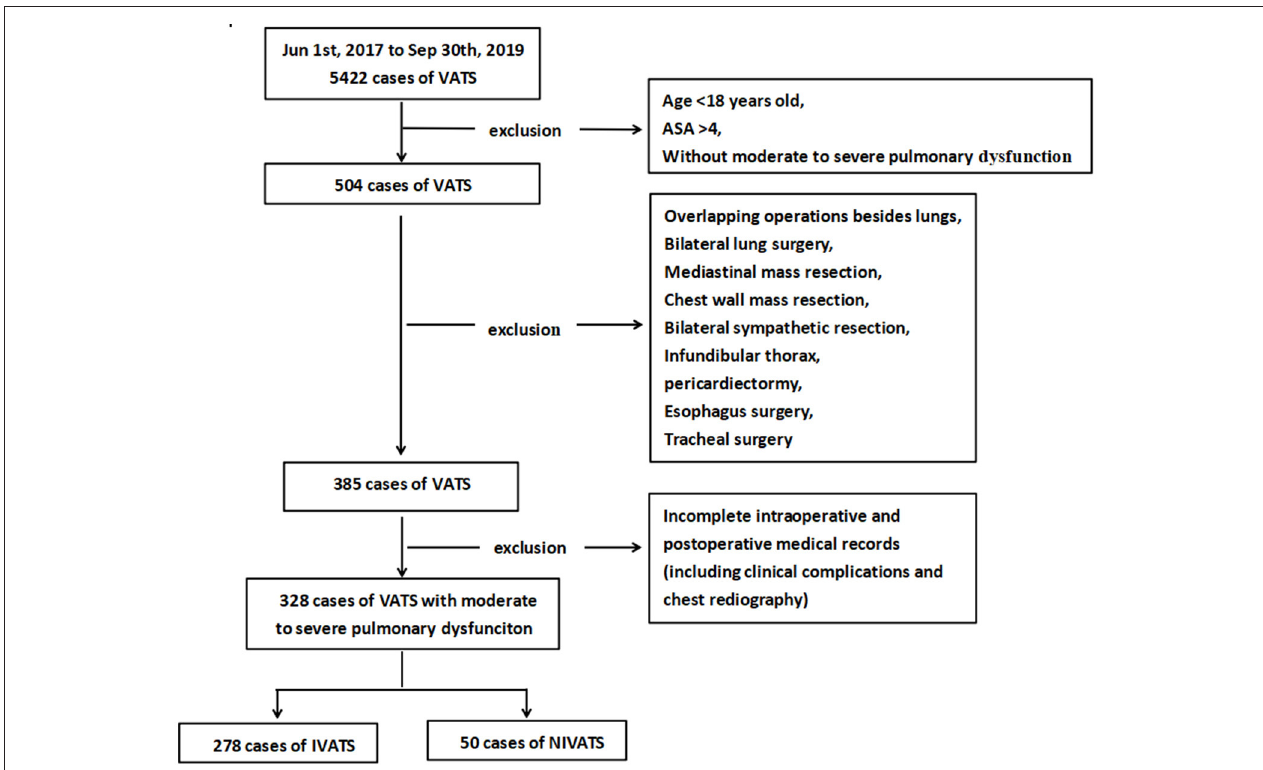
FIGURE 1 | Flow chart of data collection. VATS, video-assisted thoracic surgery; NIVATS, non-intubated video-assisted thoracic surgery; IVATS, intubated video-assisted thoracic